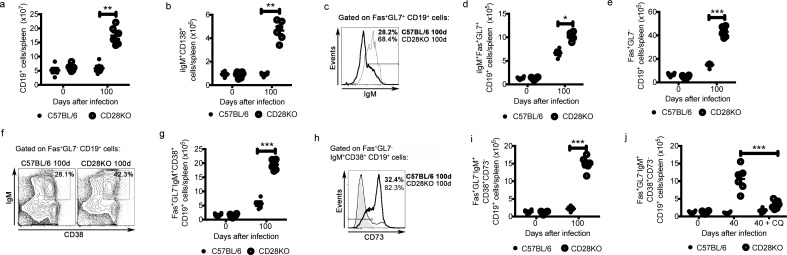
Expansion of the IgM+ memory B cell population in the spleens of chronically infected C57BL/6 and CD28KO mice.(a-i) Splenic B cells were analyzed in mice on day 100 p.i. and in age-matched controls (0d). (a) The CD19+ cell numbers per spleen. (b) The iIgM+CD138+ cell numbers per spleen. (c) Representative histograms obtained by flow cytometry showing IgM expression in Fas+GL7+CD19+ cells. The IgM+ cell percentage data are shown. (d) The Fas+GL7+IgM+CD19+ cell numbers per spleen. (e) The Fas+GL7-CD19+ cell numbers per spleen. (f) Representative contour plots obtained by flow cytometry showing IgM and CD38 expression in Fas+GL7-CD19+ cells. The IgM+CD38+ cell percentage data are shown. (g) The Fas+GL7-IgM+CD38+CD19+ cell numbers per spleen. (h) Representative histograms obtained by flow cytometry showing CD73 expression in Fas+GL7-IgM+CD38+CD19+ cells. The CD73- cell percentage data are shown. (i) The Fas+GL7-IgM+CD38+CD73-CD19+ cell numbers per spleen. (j) The Fas+GL7-IgM+CD38+CD73-CD19+ cell numbers per spleen at day 40 p.i. in mice that were or were not treated with chloroquine (CQ). In a-j, significant differences (*p<0.05, **p<0.01, ***p<0.001) between the indicated groups are shown. Data from three independent experiments (n = 6, mean ± SEM) is shown.